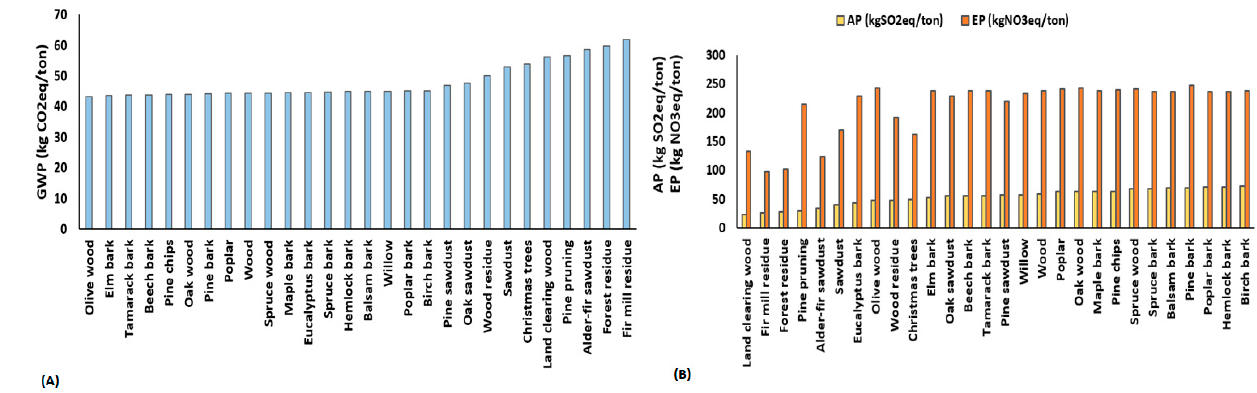
Figure 5. Environmental impact assessment of various WB&FR gasifications: ( A ) GWP, ( B ) AP, and EP.